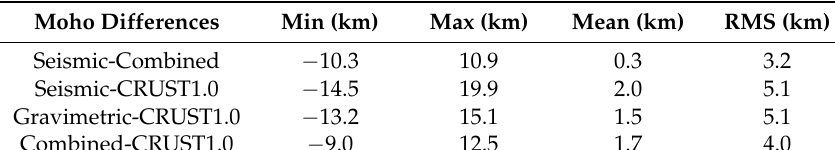
Table 3. Statistics of the regional Moho depth differences.